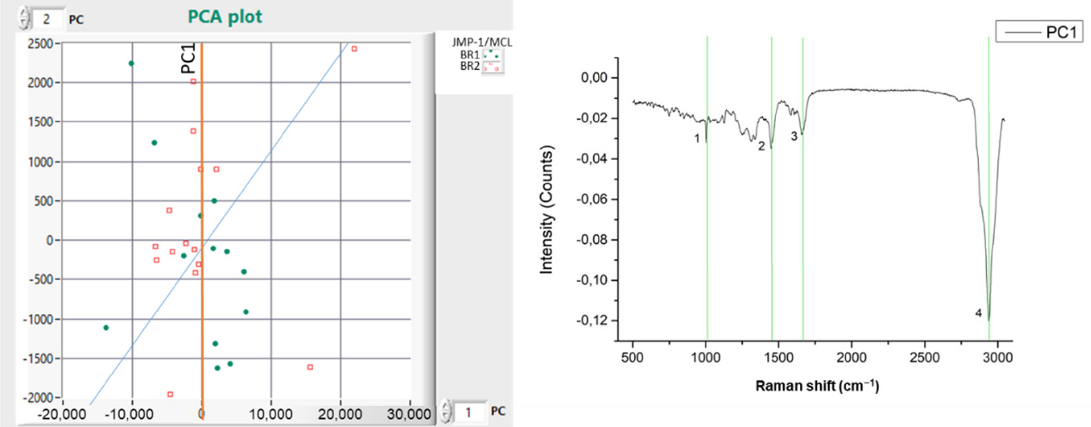
Figure 3. ( left ) PCA plot between measurements of two distinct experimental periods of from the same cell line. Green is BR1, Red is BR2 (JMP-1/MCL NHL); ( right ) PC Raman spectra showing the cell line differences. Table 2. Major Raman peaks found in PC1 between BR1 and BR2 analysis.